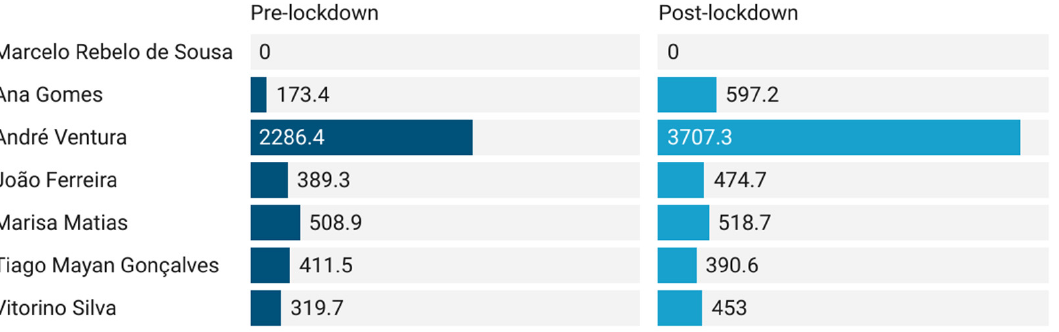
Figure 6. Online campaigning before and after the January 2021 lockdown was declared (average engagement per content on social media). Source: Own data (see Section 3.1.2).